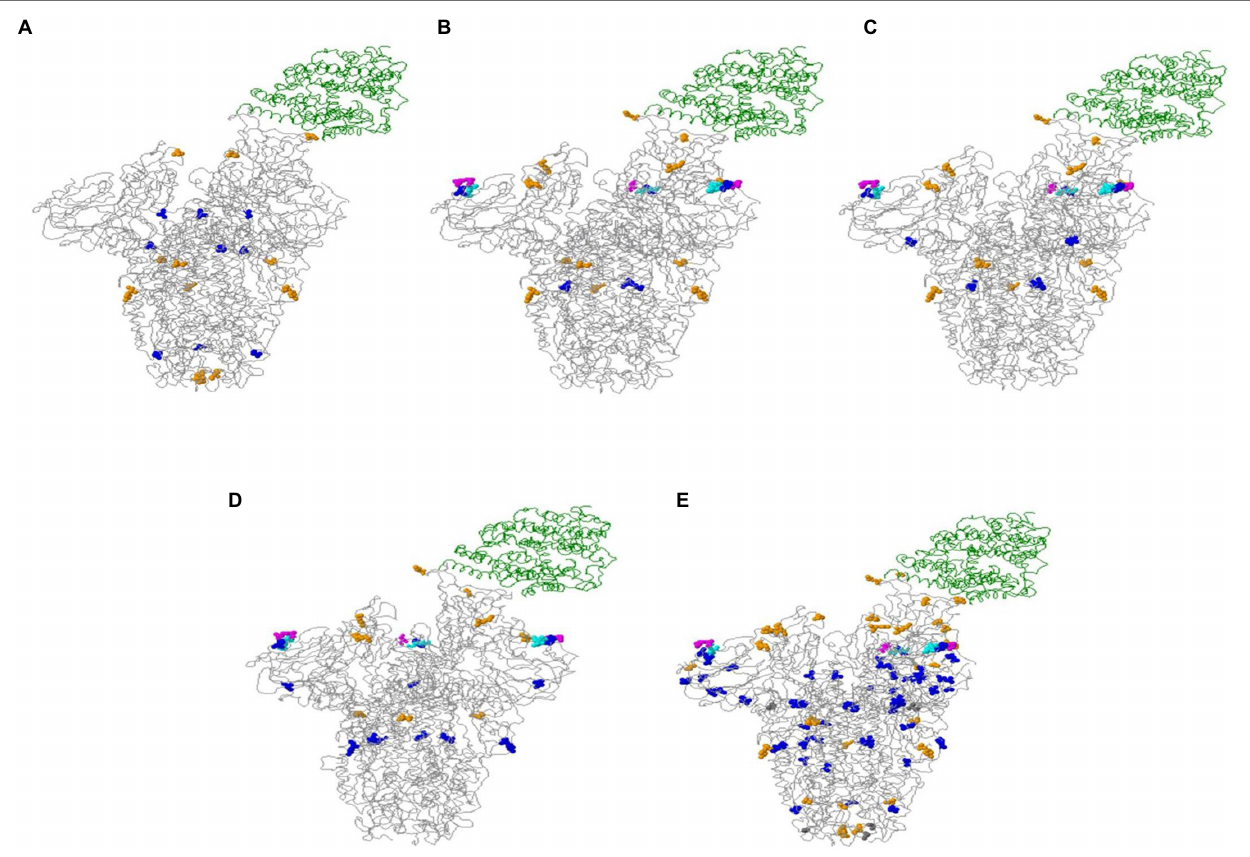
FIGURE 5 | Spike glycoprotein associated with the host cell receptor ACE2 (green ribbon). (A) 20I (Alpha variant); (B) 21A (Delta variant); (C) 21I (Delta variant); (D) 21 J (Delta variant); and (E) overall changes in all sequences tested. Colored balls present amino acid variations: A222V, A570D, A871S, D138Y, D178H, D178Y, D614G, D950N, E156G, E484K, G181V, H655Y, Q173H, Q613H, Q677H, S982A, T95I, T572I, T716I, W64R in blue. A899S, D1118H, E484Q, L452R, N501T, N501Y, P681H, P681R, R346S, T478K, W152R in orange. A292V, G1124R in gray. F157del, R158del in turquoise. T19R in